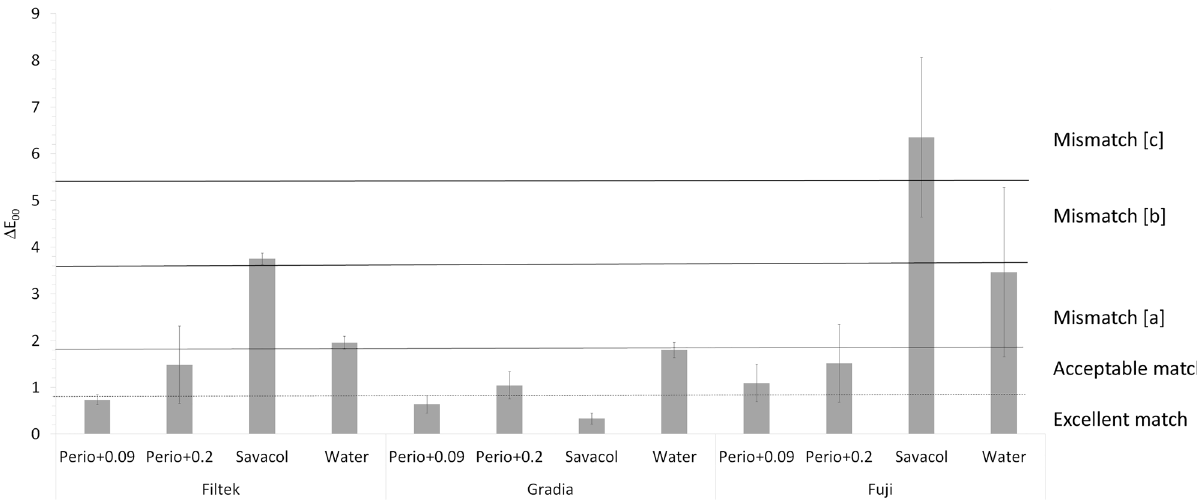
Figure 1. CIEDE2000 colour differences (ΔE 00 ) for tested materials 23 . Excellent match (ΔE 00 ≤ 0.8), acceptable match (0.8 <